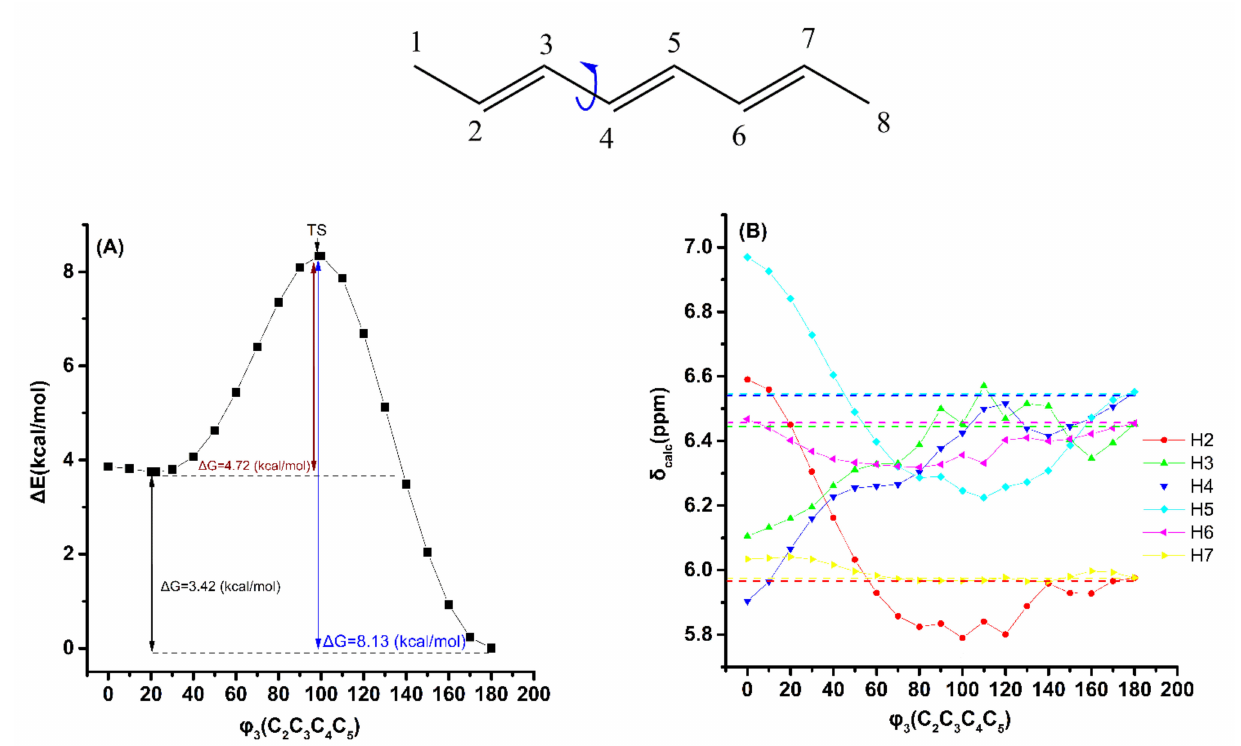
Figure 6. Effect of variation in the torsion angle ϕ 3 (C 2 C 3 C 4 C 5 ) of ( E , E,E )-2,4,6-octatriene, with energy minimization at the B3LYP/6–31+G(d) level, on the electronic energy ∆ E (kcal/mol) (characteristic ∆ G values are also shown) ( A ) and on 1 H) data of the olefinic protons (at the GIAO/B3LYP/6–311+G(2d,p) level of theory with CPCM in CCl δ calc ( experimental chemical shift values are denoted with the horizontal dotted